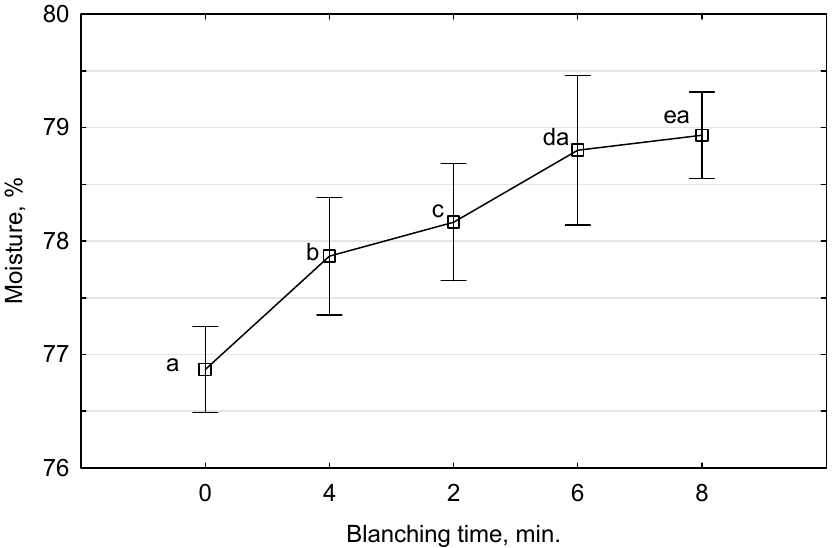
Figure 1. The influence of the blanching time on kernel moisture including 95% confidence intervals. Means with the same letter are significantly different from each other ( p < 0.05). Kachhadiya et al. [18] observed similar relationships while blanching sweet corn kernels. Moisture content significantly increased from 76% to 80.2% in hot water